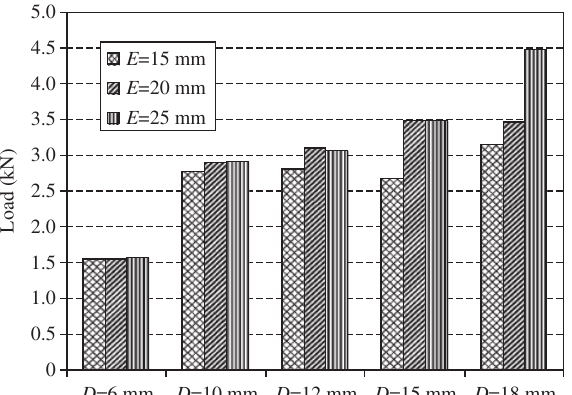
Figure 11 Average maximum load values carried by the samples.